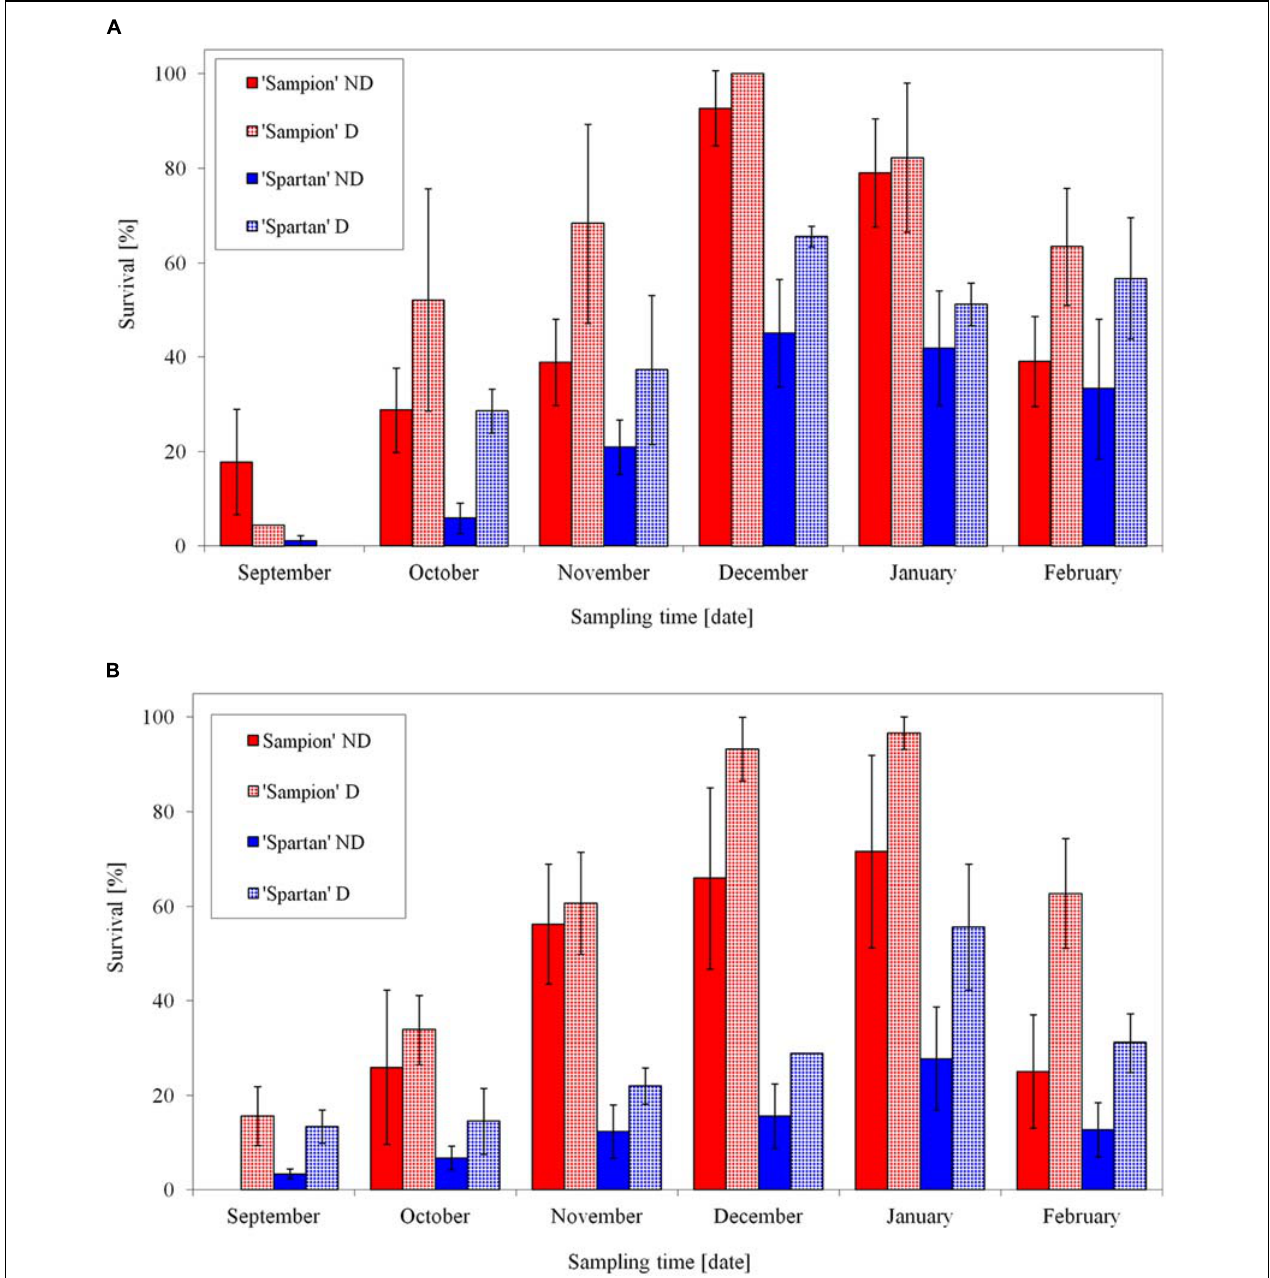
FIGURE 7 | Average survival from three seasons of 1998/1999, 1999/2000, and 2000/2001 of vegetative buds of apple cultivars ‘Sampion’ and ‘Spartan’ after the first step of cryopreservation protocol at –30 ◦ C (A), and after the second step, reaching the LN temperature (B). ND variant was cryopreserved immediately after sampling from the orchard. D variant was cryopreserved after frost dehydration of at least 1 week at –4 ◦ C. Survival was tested by examination of oxidative browning of tissues on the longitudinal cut of the bud. Water content was measured immediately before cryopreservation procedure. Bars indicate SD ( p <